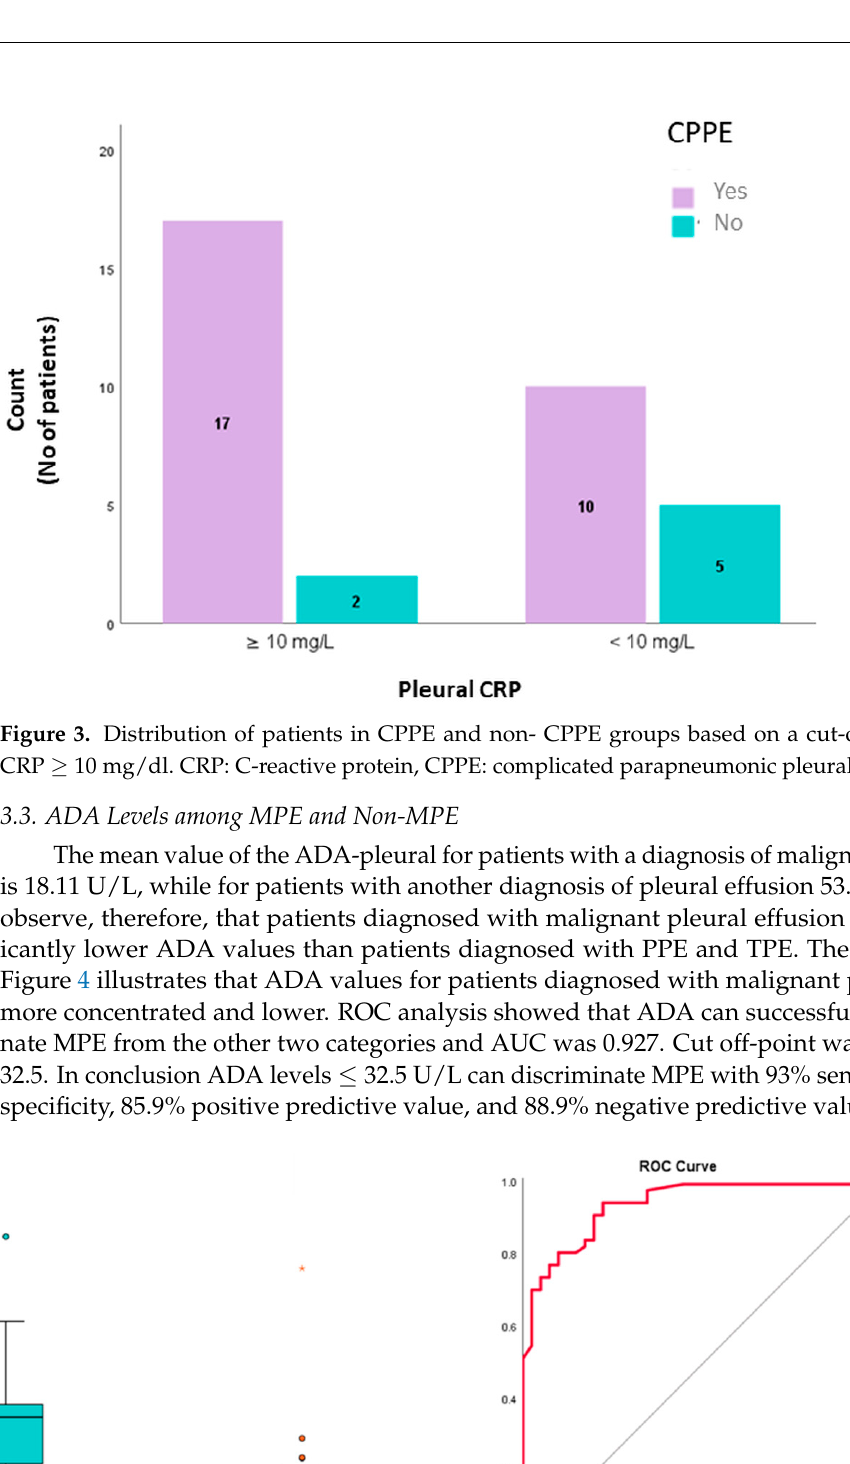
Figure 4. A . Boxplot of ADA levels of non-MPE and MPE. B. ROC curve of ADA levels for differentiating malignant pleural effusions from other types of pleural effusions. MPE: malignant pleural effusions, ADA: adenosine deaminase.